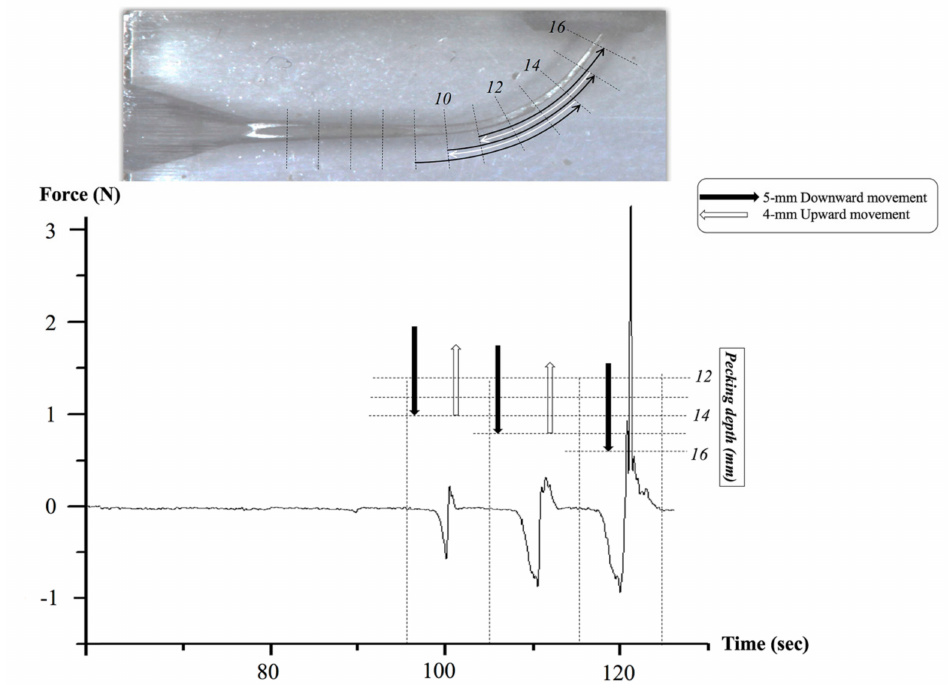
Figure 3. Representative strip-chart of screw-in forces during instrumentation using WaveOne Gold Primary. Negative and positive values indicate the screw-in and apical driving forces, respectively. Repeating 5 mm downward (black arrow) and 4 mm upward (white arrow) movement, the files approach the working length (16 mm) over time. The incremental penetration depth at each stroke was 1